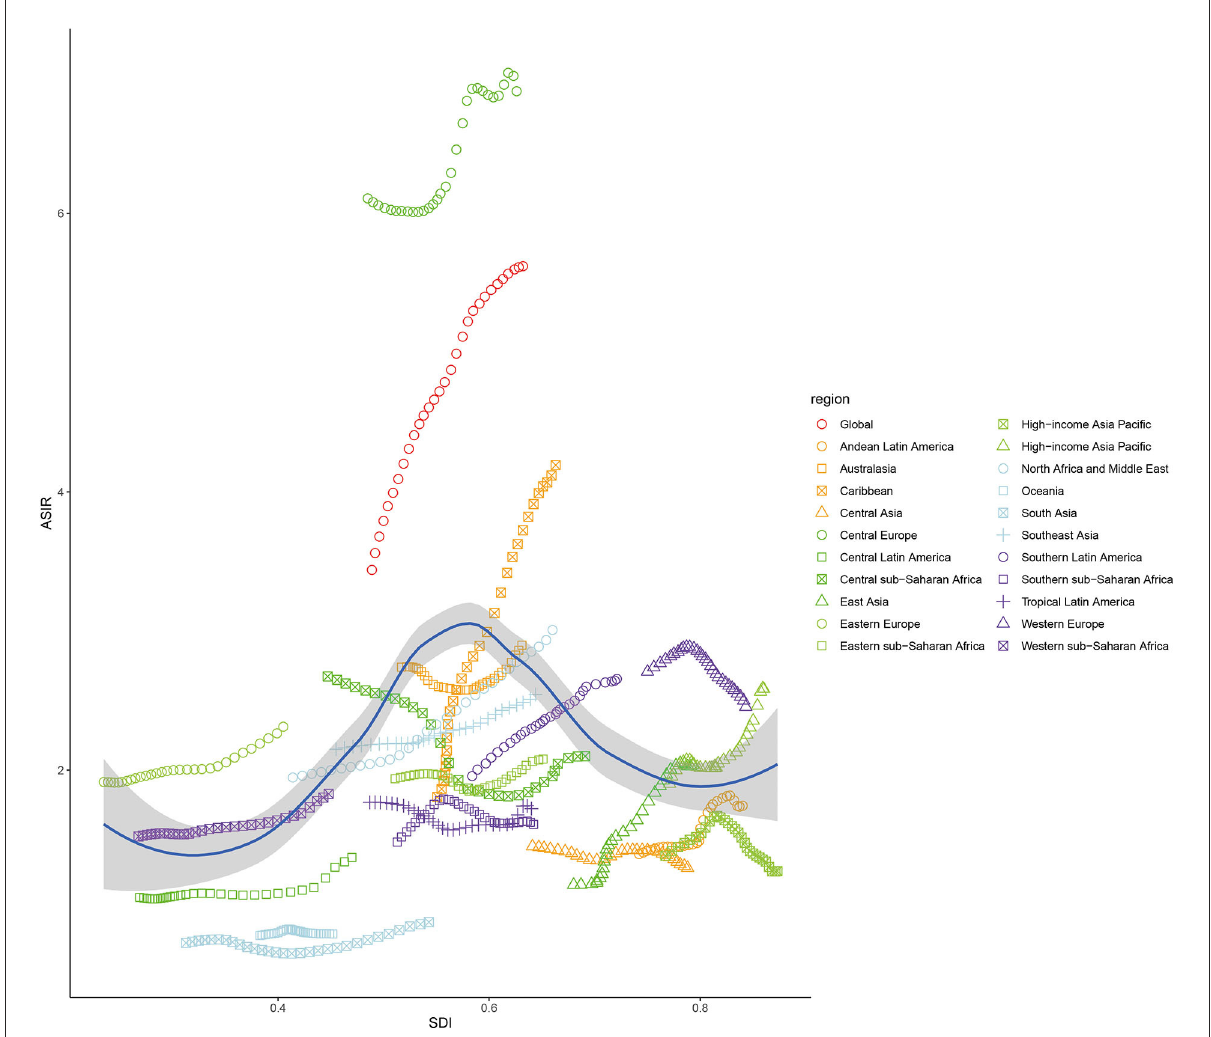
FIGURE3 Correlation between SDI index and